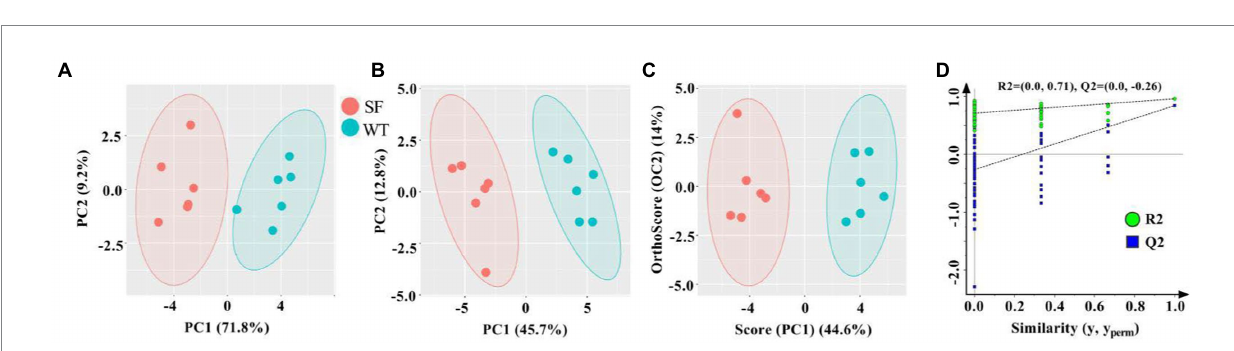
FIGURE 3 Multivariate analysis of the volatile components in meats from two donkey strains. Principal component analysis (PCA) (A) , partial least squares discriminant analysis (PLS-DA) (B) , and orthogonal PLS-DA (C) score plots based on flavoromics data. Corresponding OPLS-DA validation plots (D) . SF, Sanfen; WT,